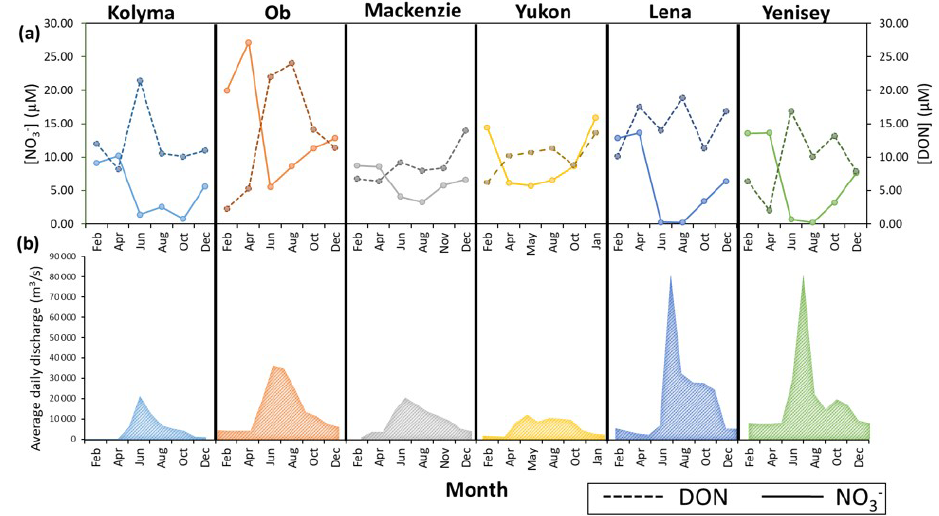
Figure 6. Seasonal concentrations (a) for nitrate and DON in the six Arctic GRO rivers between 2003 and 2018. Discharge trends for each river are also shown in (b) . Note, sample concentration values were taken six times throughout the year, every second month. The daily discharges for each month were averaged to produce the average daily discharge value for each month, 12 per year. Data are obtained from the ArcticGRO online